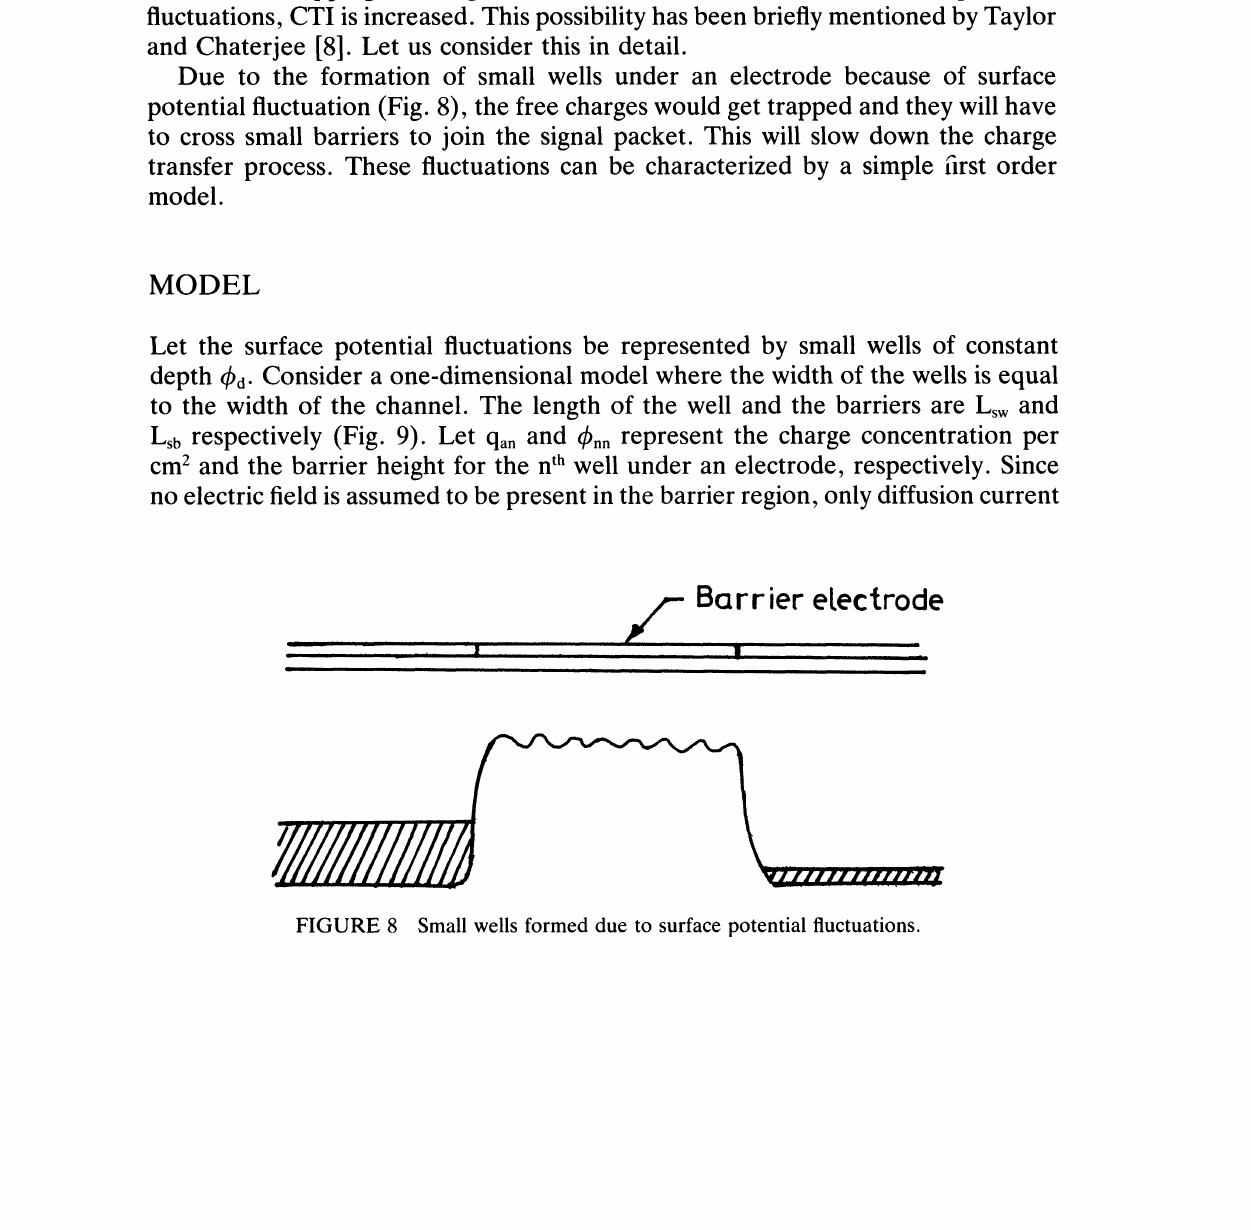
FIGURE 8 Small wells formed due to surface potential